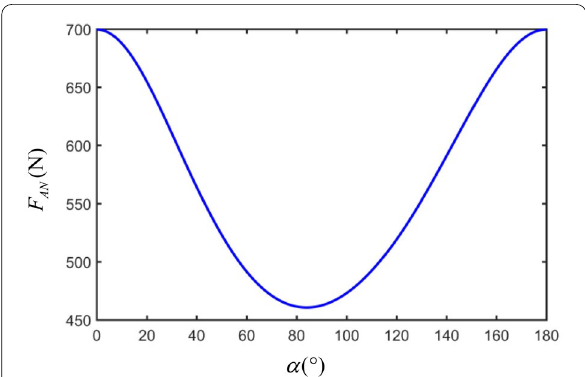
Figure 10 Thrust F AN under mechanism deformation